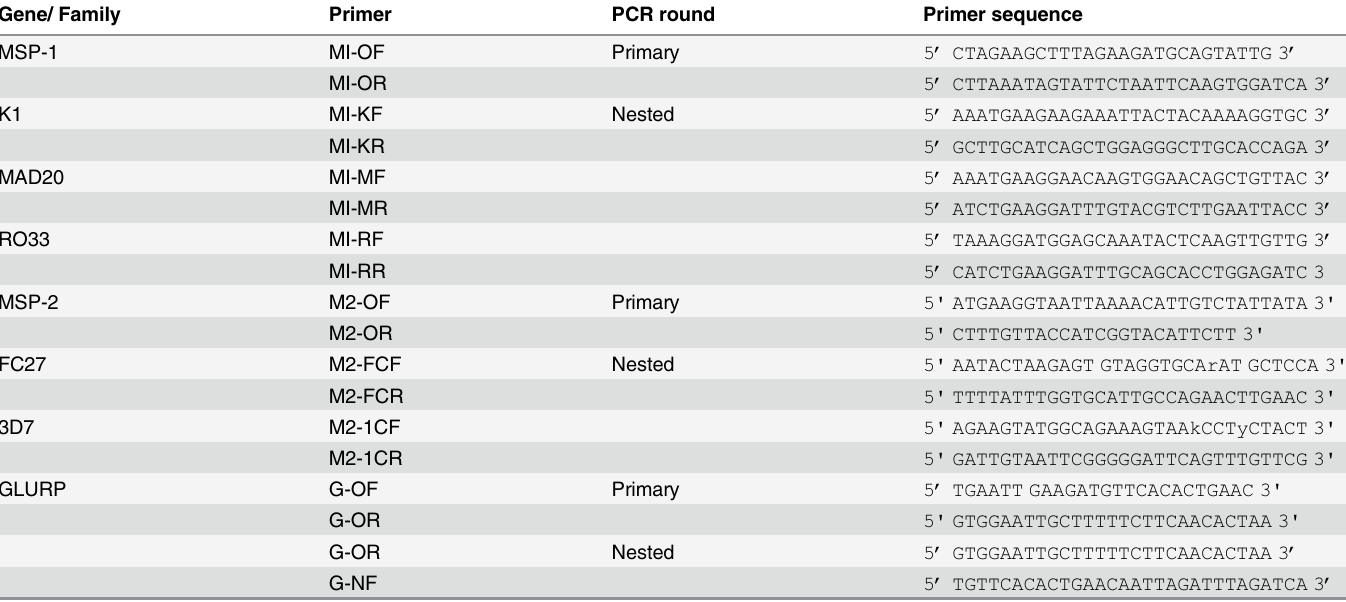
Table 1. The primers used to genotype the MSP-1, MSP-2 and GLURP polymorphic regions of P . falciparum isolates from Kalabakan and Kota Mar- udu,